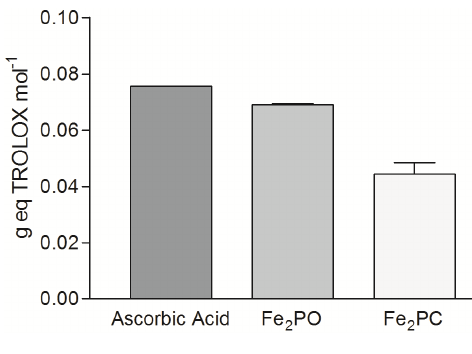
Figure 7. Antioxidant capacity of Fe Ascorbic acid and a solution of Fe(III) were used as a controls. Bars represent the standard error of the mean (±SEM) of triplicate experiments. Ferric chloride had no detectable antioxidant capacity and was not